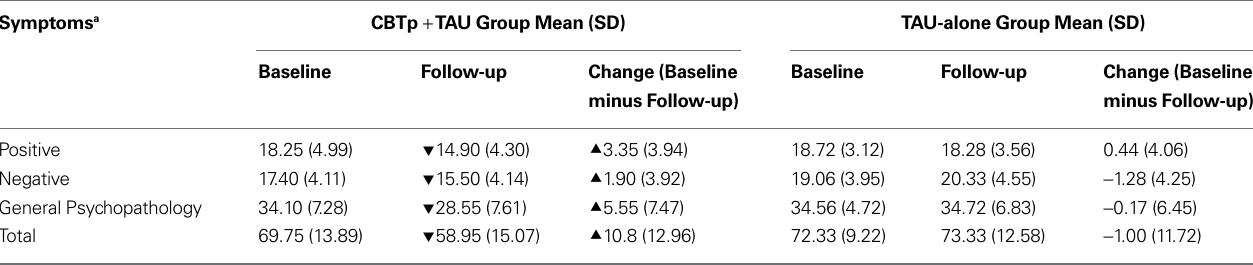
Table 2 | Symptoms and symptom changes in the CBTp + TAU and TAU-alone patient groups. Symptoms a CBTp + TAU Group Mean